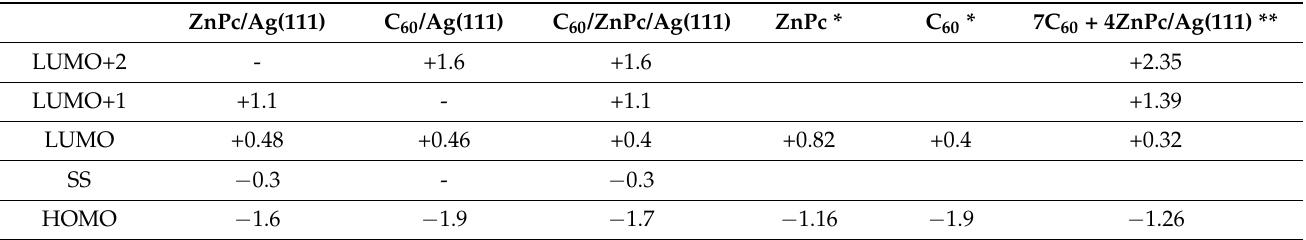
Figure 2. STM topography and differential conductance spectra for ( a ) C 60 molecule islands grown on ZnPc/Ag(111). For comparison: ( b ) C 60 molecules on Ag(111); the topograph shows contrasts of either the topmost hexagon ring or the 6:6 bond separating two adjacent hexagon rings of the C 60 molecule. ( c ) Face-on ZnPc molecules on Ag(111). For the dI/dV spectroscopy, the feedback loop was opened at 0.7 nA and − 0.3 V. Table 1. Experimental energy levels in